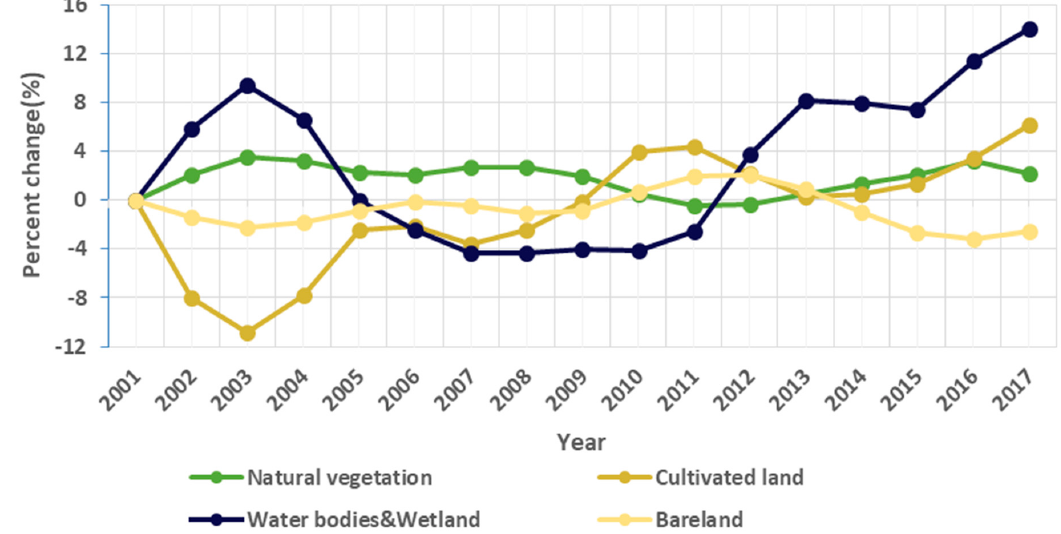
Figure 7. Rate of land area change for various land cover types in the study area from 2001 to 2017. The rates indicate the rate of change of area in a certain year relative to 2001.